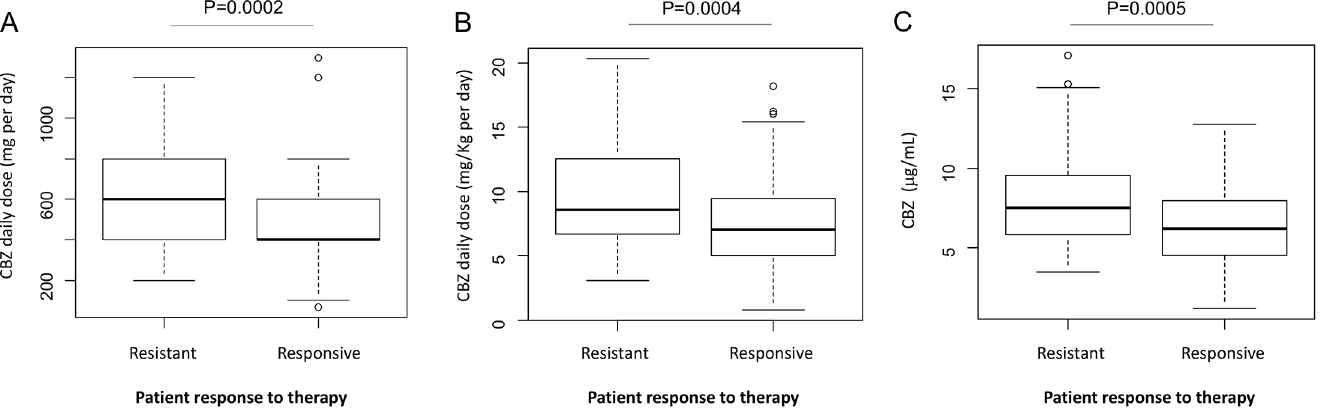
Fig 6. Graphical representations (box-plot) of the assessment of CBZ resistance due to patient response to therapy (A) CBZ daily dosage (mg/ day), (B) CBZ maintenance dose (mg/kg per day) and (C) CBZ plasma concentration ( μ g/mL). Data are mean ± standard deviations. Statistical significance for difference of means is shown (P values, Student ’ s